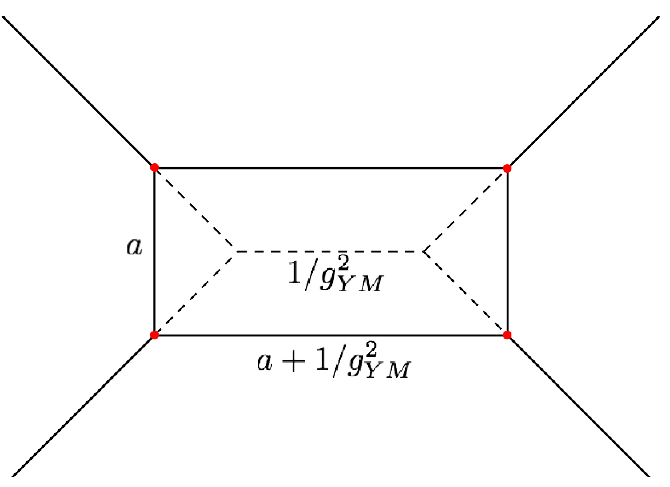
Figure 1 . P 1 (cid:2) P 1 geometry corresponding to SU(2) theory on the squashed (cid:12)ve-sphere. The non-perturbative topological string computed from this geometry is to be integrated over a